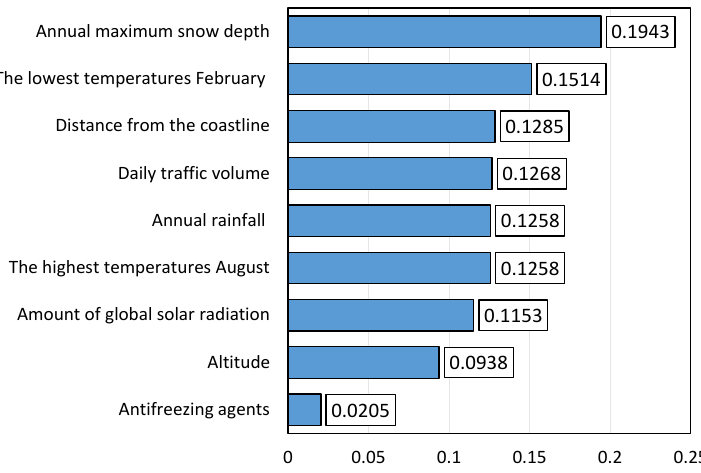
Figure 15. Range in concrete beams that have been in service for 20 – 30 years.